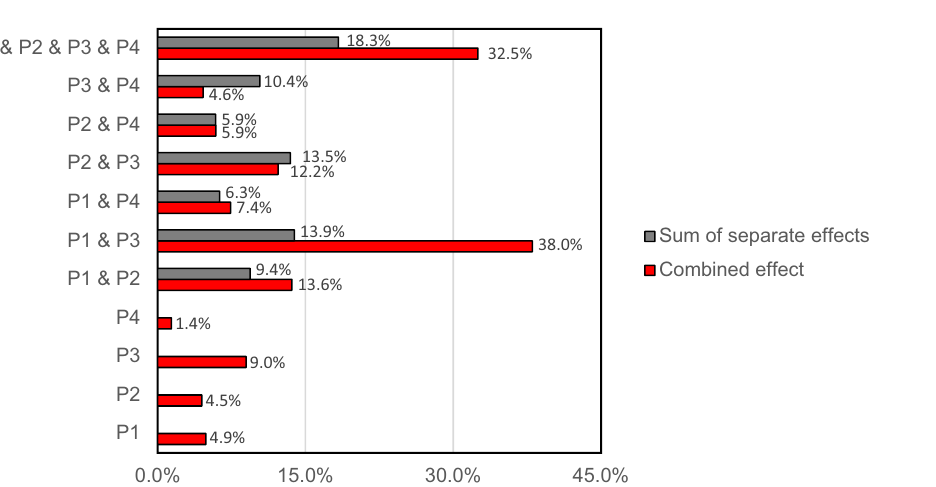
Figure 10. The nonlinear effect of policies. The benefits of implementing multiple policies differ from the sum of the effect of policies. The figure shows the percent of burn rate reduction. Note: P1: limit vulnerable property development; P2: prescribed burning; P3: effective firefighting; and P4: Clear